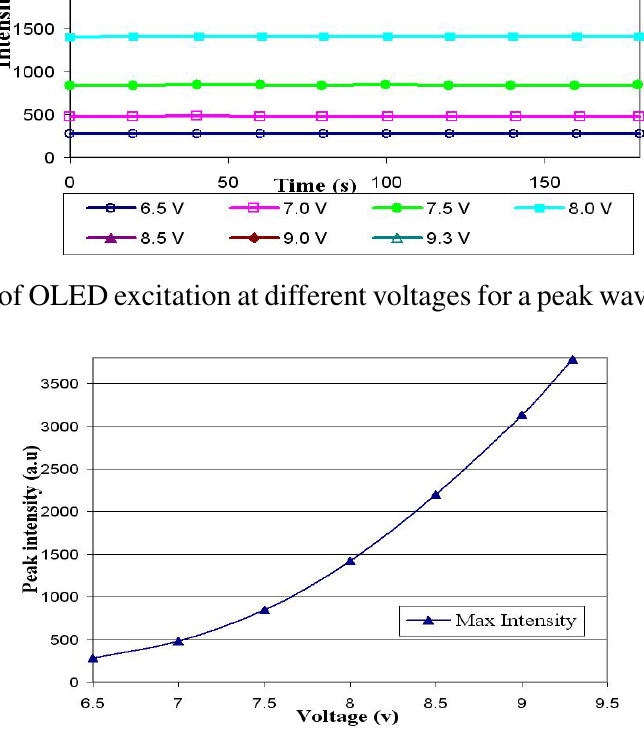
Figure 7. Variation of peak intensity of OLED emission for different voltages at 496 nm wavelength.